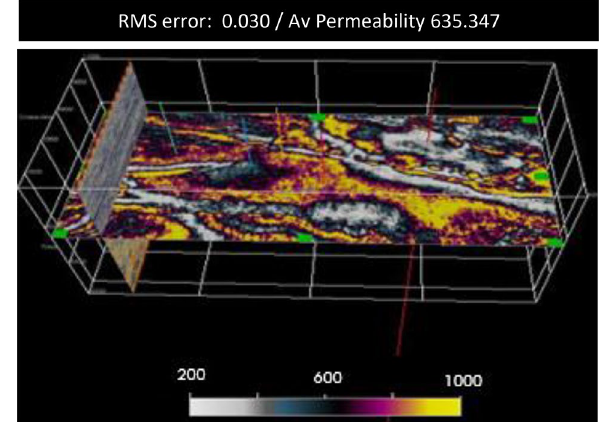
Fig. 14 MLPNN data preparation and training interface for hydrocar- bon saturation modelling